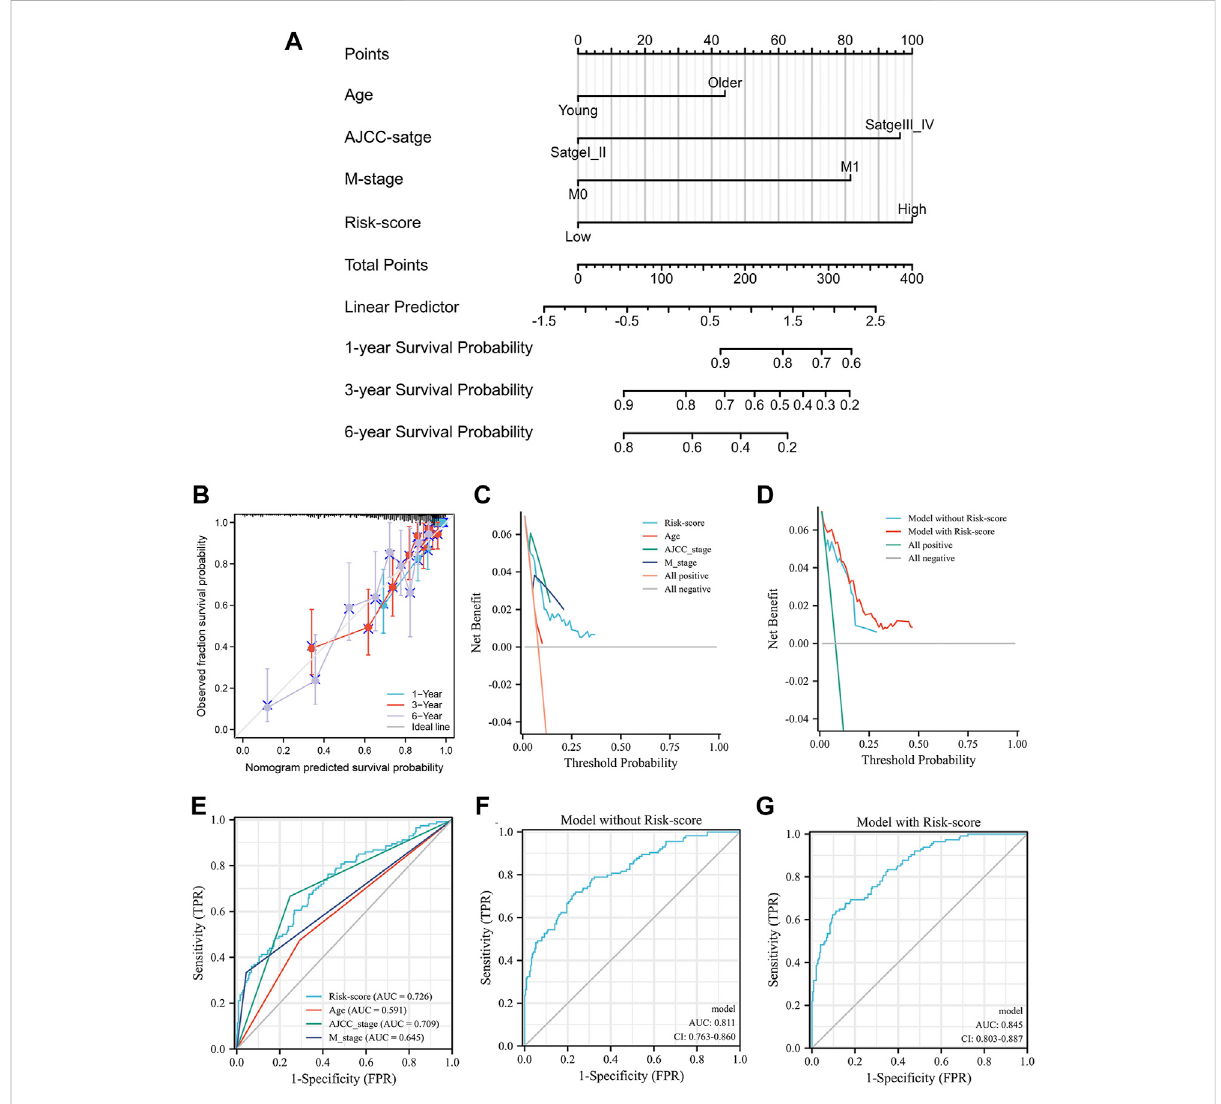
FIGURE 7 The nomogram of the in fl ammation-related gene signature and its performance: the nomogram (A) , the calibration curves of the nomogram (B) , the calibration curves of different factors (C) and the nomogram (D) , the result of ROC analysis with different factors (E) , the result of multiparameter ROC analysis without the risk scores (F) , the result of multiparameter ROC analysis with the risk scores (G) .